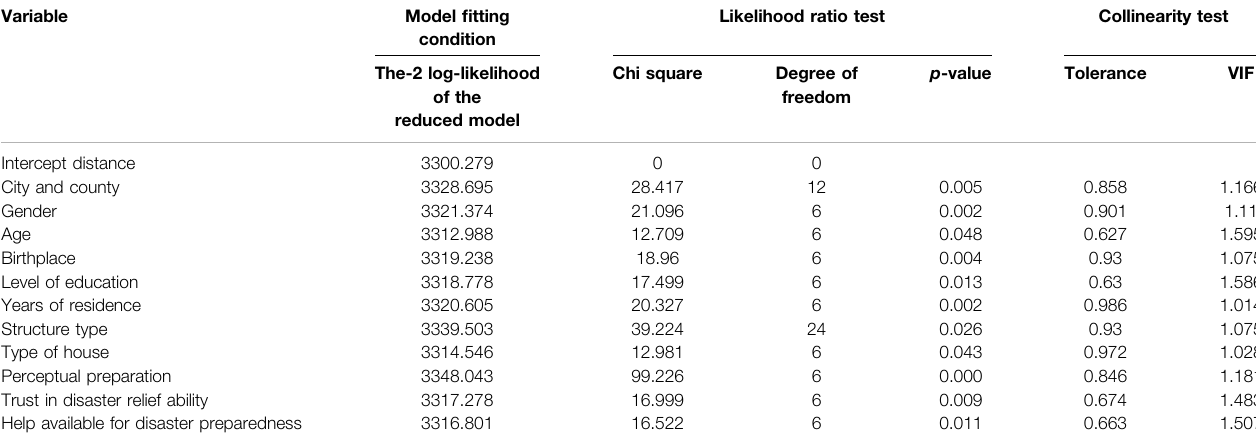
TABLE 6 | Multiple collinearity and independent variable likelihood ratio test. Variable